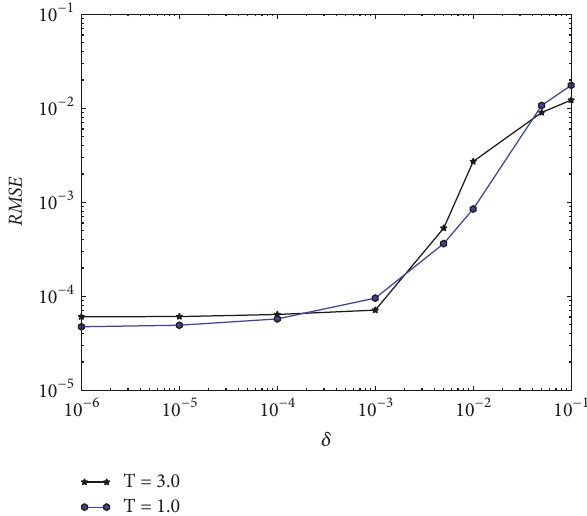
Figure 8: The square domain with computational grid. Figure 9: The errors of RMSE with different 𝛿 , 𝑇 = 1.0 and 𝑇 = 3.0